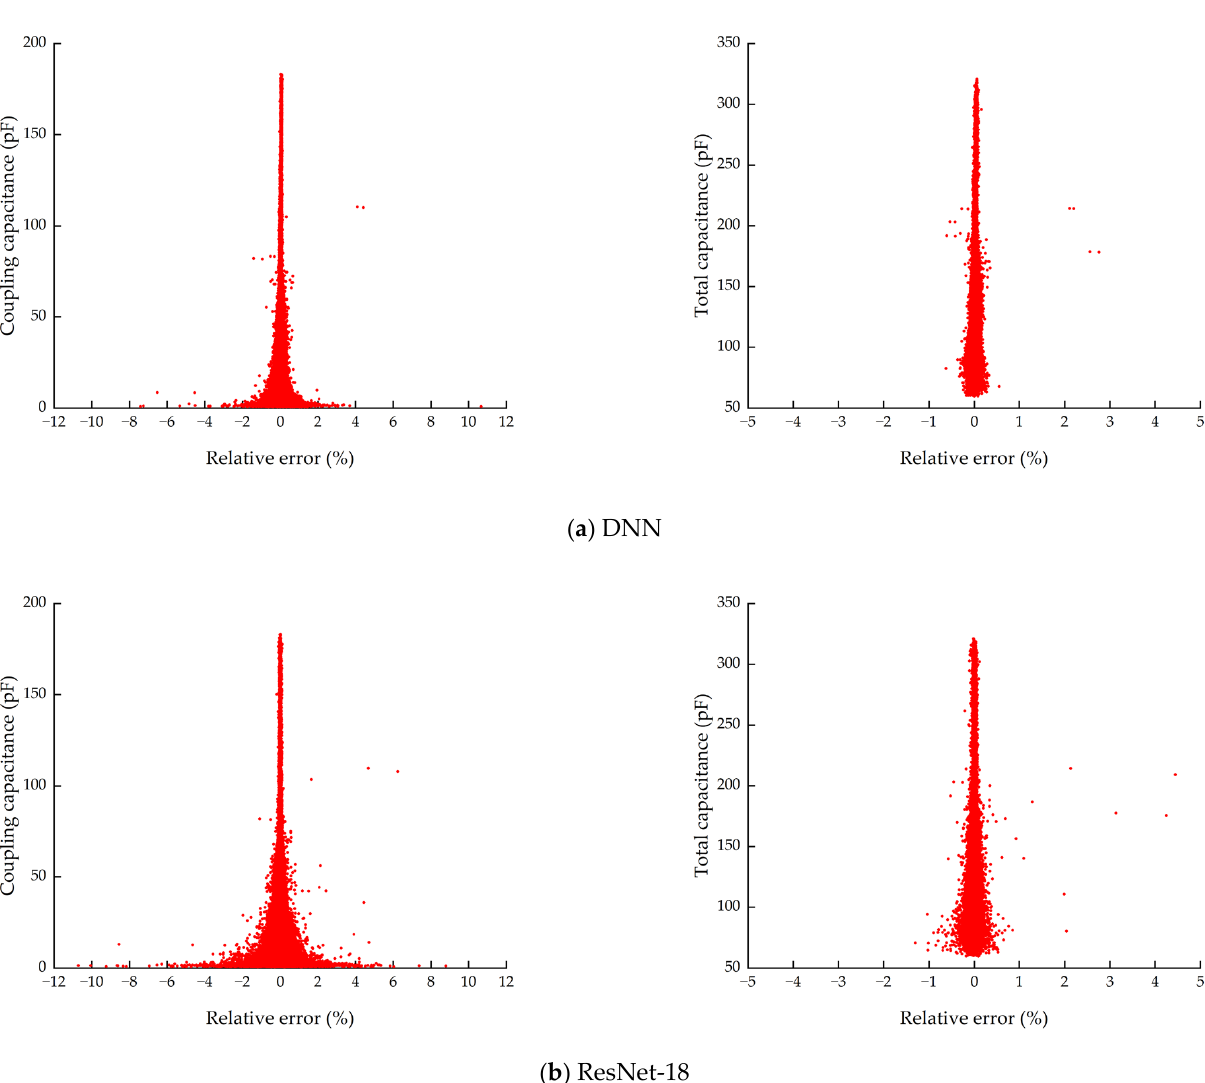
Figure 11. T he relative error distribution of the predicted coupling capacitance and total Figure 11. The relative error distribution of the predicted coupling capacitance and total capacitance: capacitance: ( a ) DNN; ( b ) ResNet-18. ( a ) DNN; ( b )